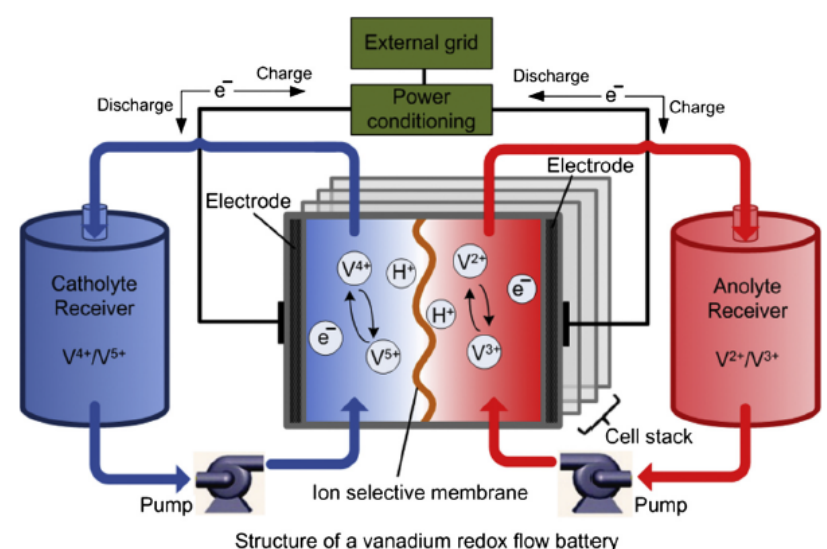
Figure 7. Schematic diagram illustrating the operation of a VRB